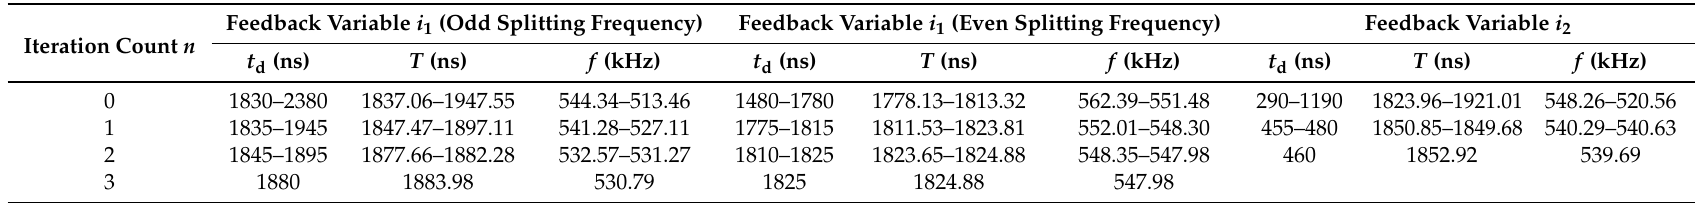
Figure 12. The iteration process of t d with different feedback variables, at different initial delay: ( a ) feedback variable i 1 ; and ( b ) feedback variable i 2 . Table 3. Range of delay, period, and frequency in each step of the delay compensation.